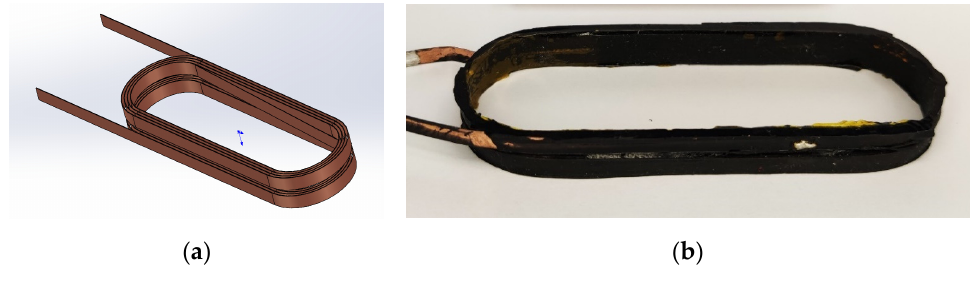
Figure 1. HTS coil. ( a ) Model; ( b ) appearance of the sample.